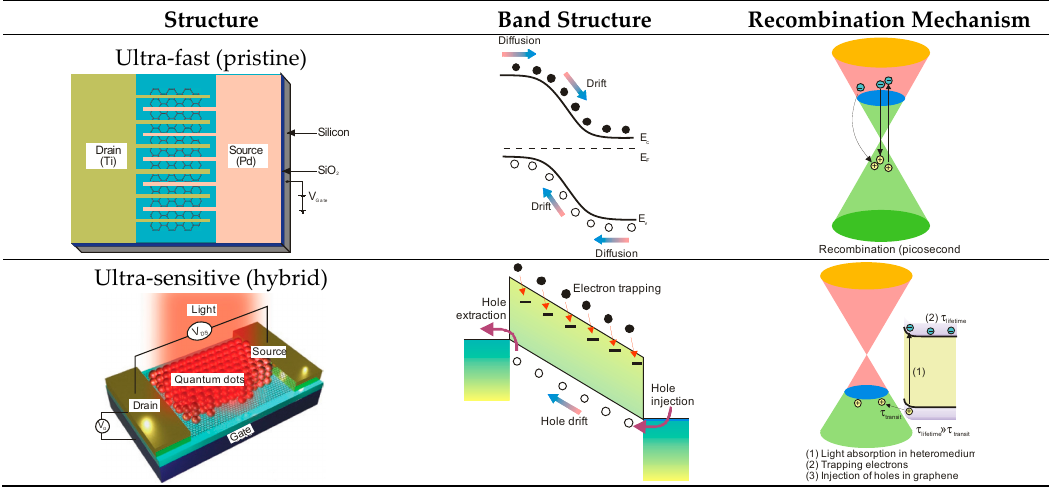
Table 1. Ultrafast and ultrasensitive graphene photodetectors. Structure Band Structure